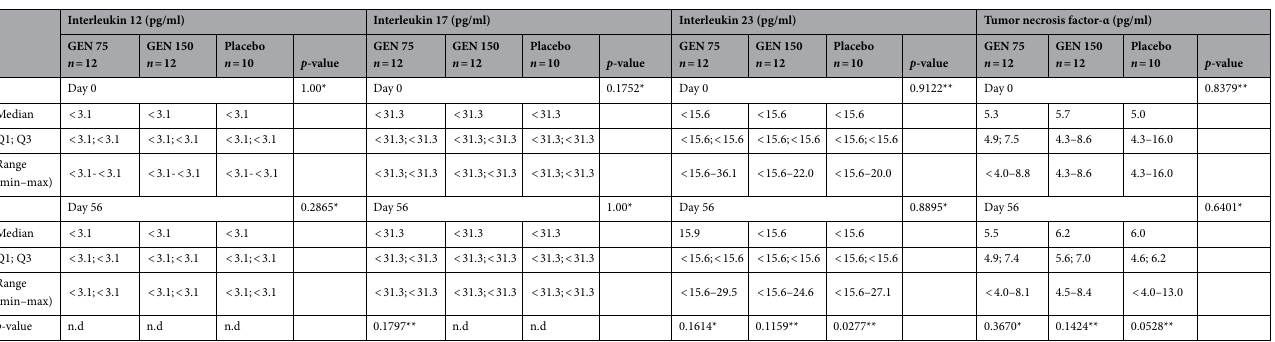
Table 3. Pharmacodynamic results of the levels of serum cytokines and comparisons before (day 0) and after (day 56) 75 mg (GEN 75) or 150 mg (GEN 150) genistein administration and genistein-untreated placebo, in total, for 34 of the 40 randomised patients. P -values of statistical significance are shown in bold. *Kruskal– Wallis test; **Wilcoxon test. n.d. shortcut stands for no data